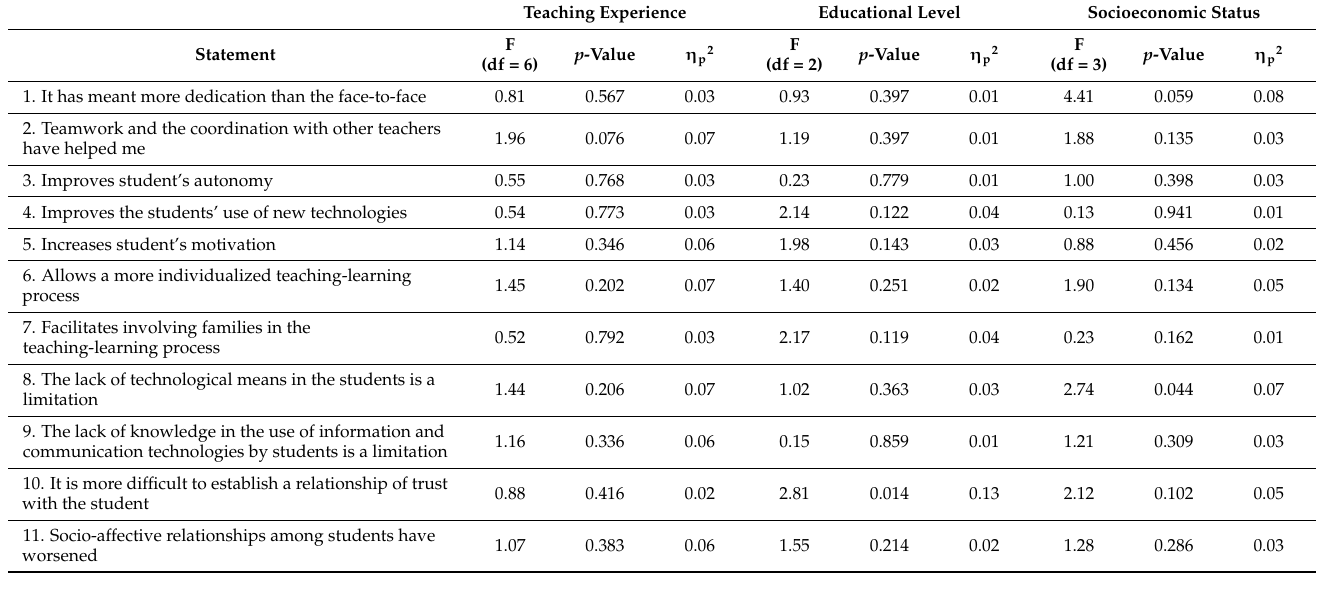
Table 3. Differences by teaching experiences, educational level, and socioeconomic status for the study variables.